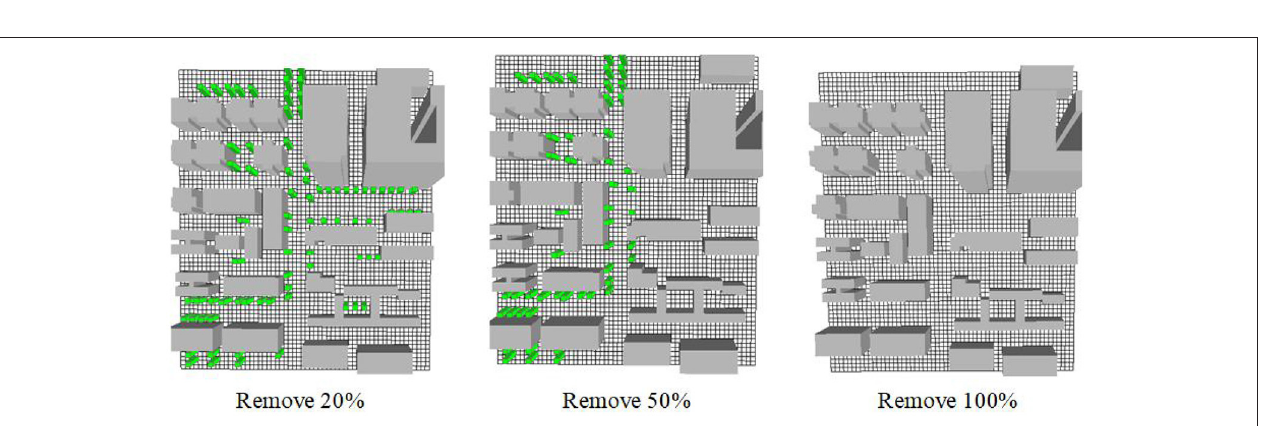
FIGURE 8 | Model of changed trees in Chigang